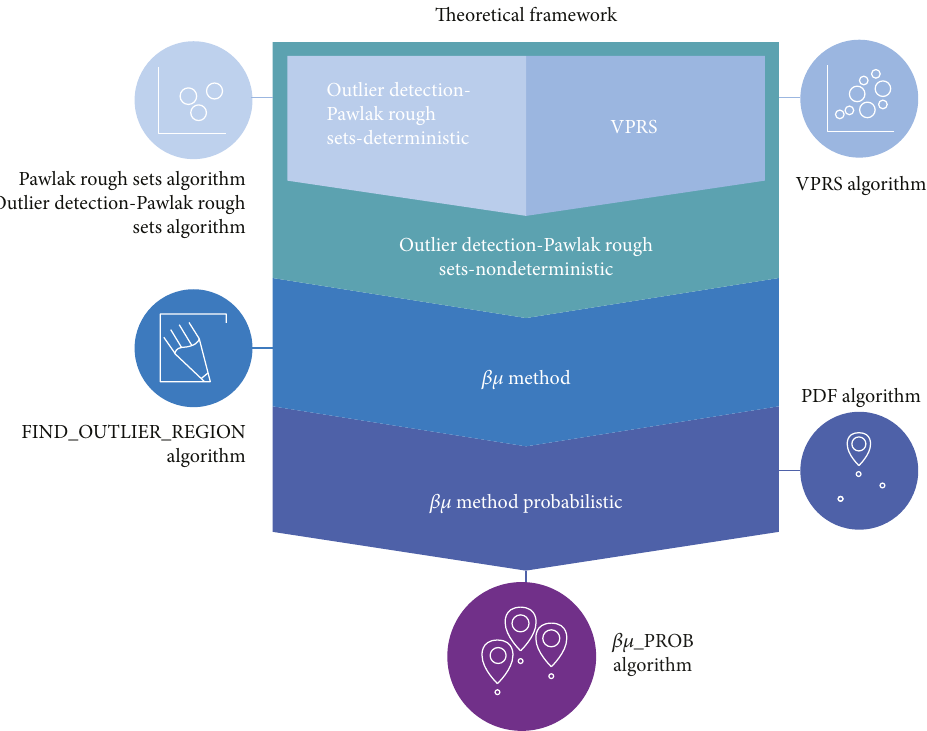
Figure 1: Global view of the theoretical